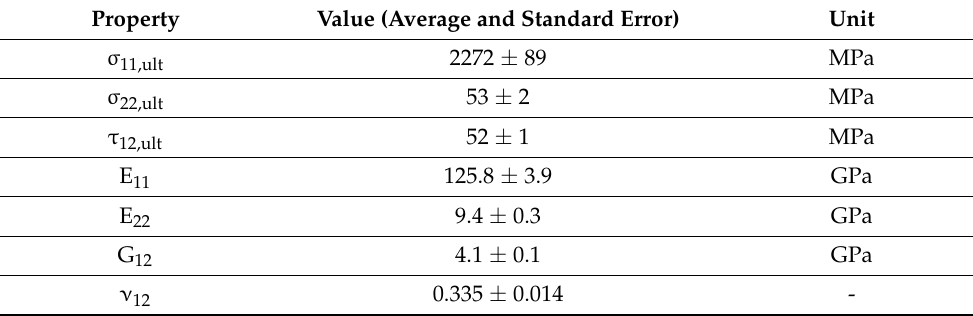
Table 1. Measured mechanical properties of the Carbon Fibre Reinforced Polymer (CFRP)